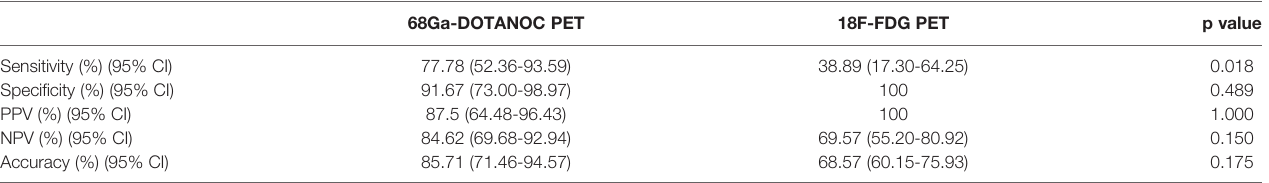
TABLE 3 | Sensitivity, speci fi city, positive and negative predictive value and accuracy for the prediction of LN group metastasis by 68Ga-DOTANOC and 18F-FDG PET through visual assessment.